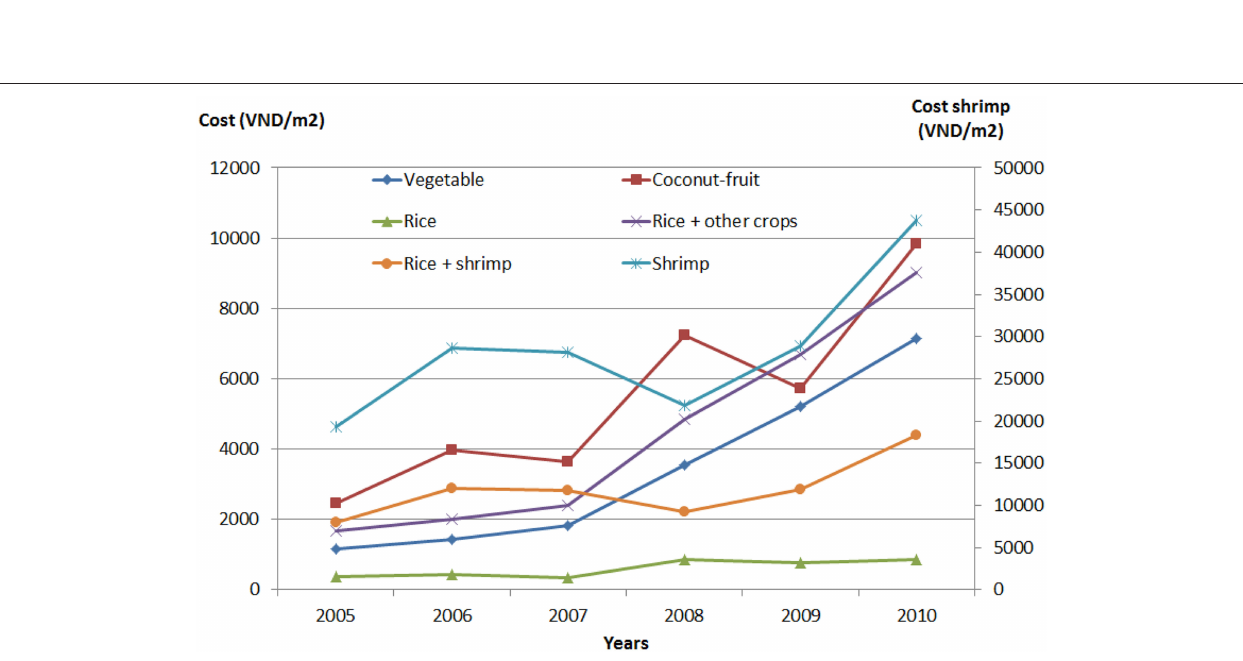
FIGURE 9 | Production costs of the most popular products in the Mekong Delta from 2005 to 2010. Source: Computed from the prices from 2005 to 2010 and the production costs in 2010 (1USD ≈ 21,840VND).